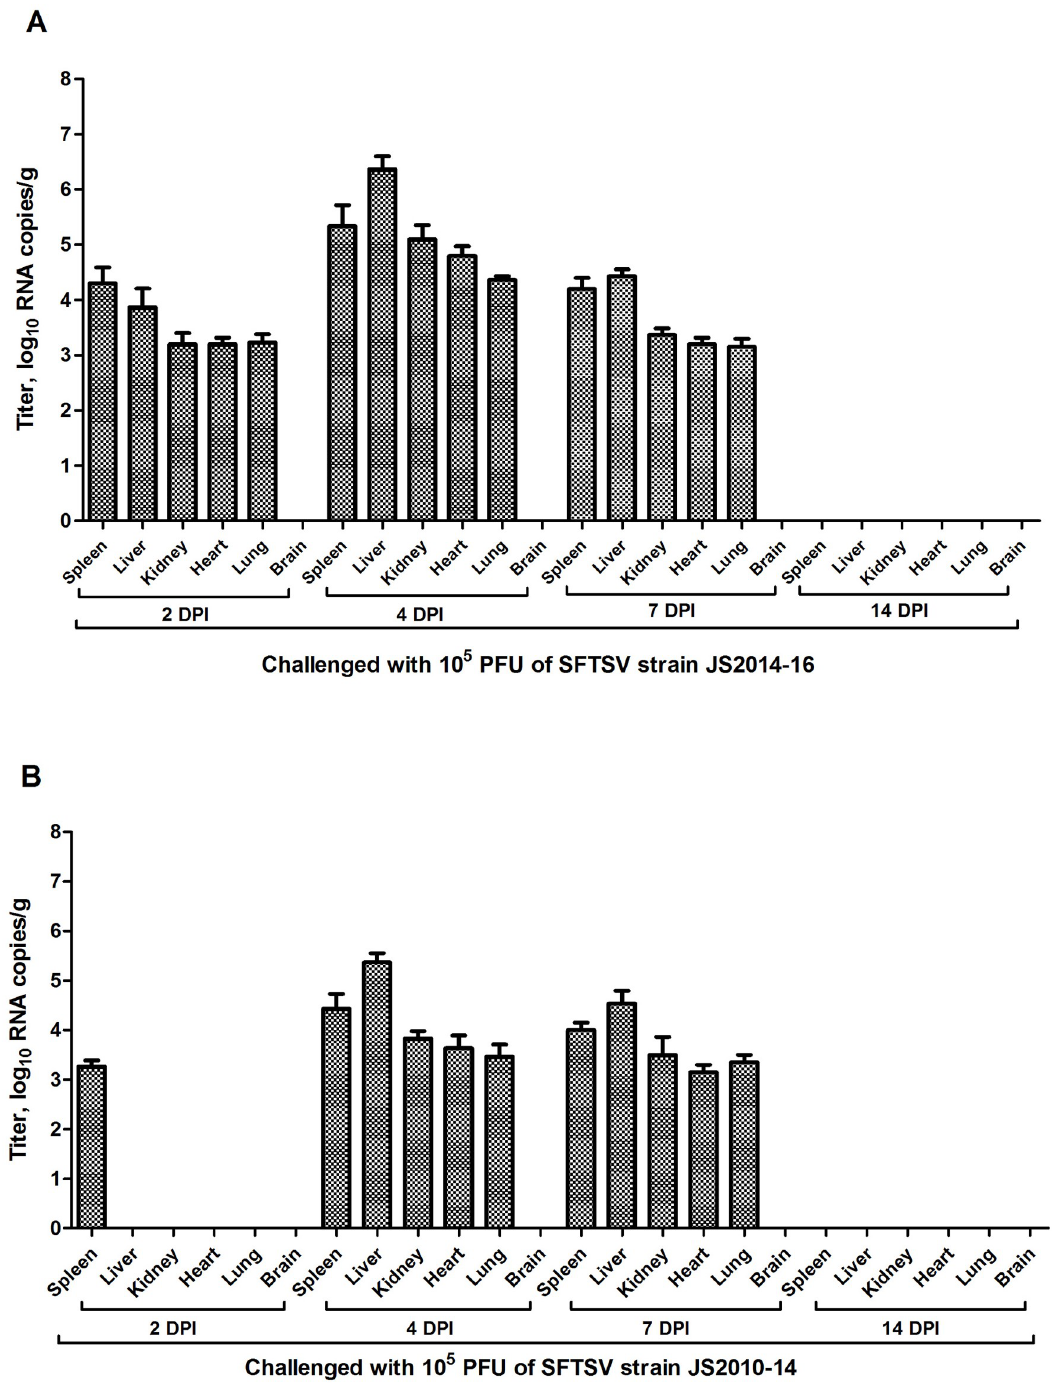
Fig 2. Viral distribution, as determined by RNA copy numbers, in organs from birds experimentally infected with 10 5 PFU of two SFTSV strains. Viral titers are represented as geometric mean ± SD. A detection limit of 0.95 log 10 RNA copies g -1 was determined. Spotted doves inoculated with 10 5 PFU of SFTSV strain JS2014 (A) had higher and earlier mean viral loads than birds inoculated with 10 5 PFU of SFTSV strain JS2010 (B).